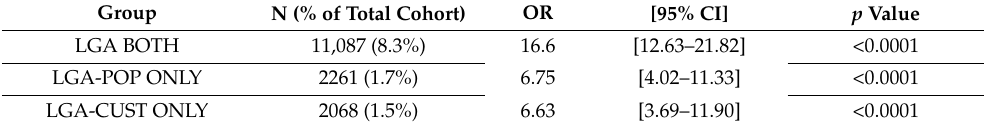
Table A5. Multivariable logistic model for shoulder dystocia in